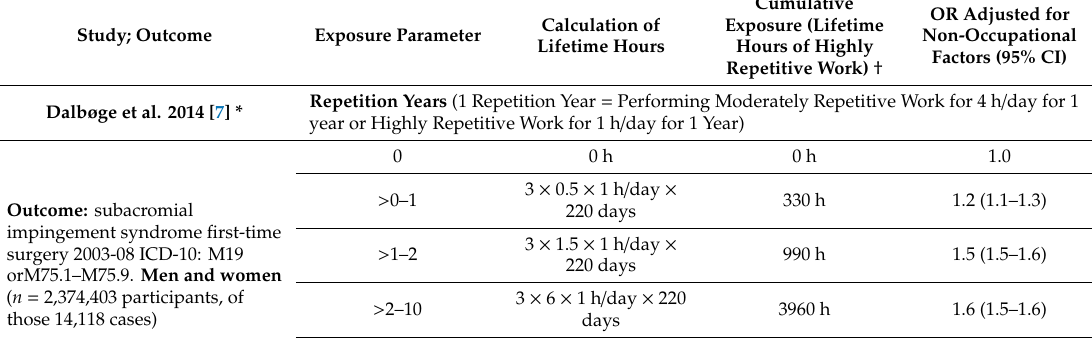
Table 4. Working with repetitive movement of the upper arm at the shoulder joint. Study; Outcome Exposure Parameter Dalbøge et al. 2014 [7]